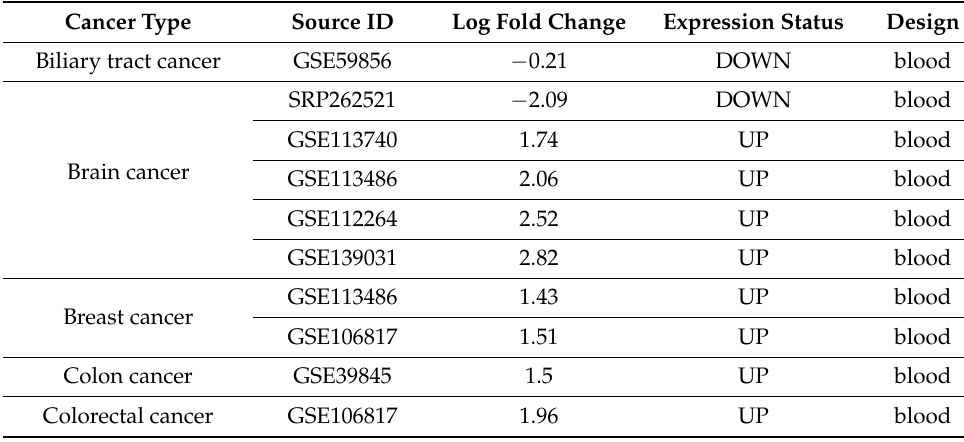
Table 2. Expression levels of miR-145-5p in liquid biopsy samples.